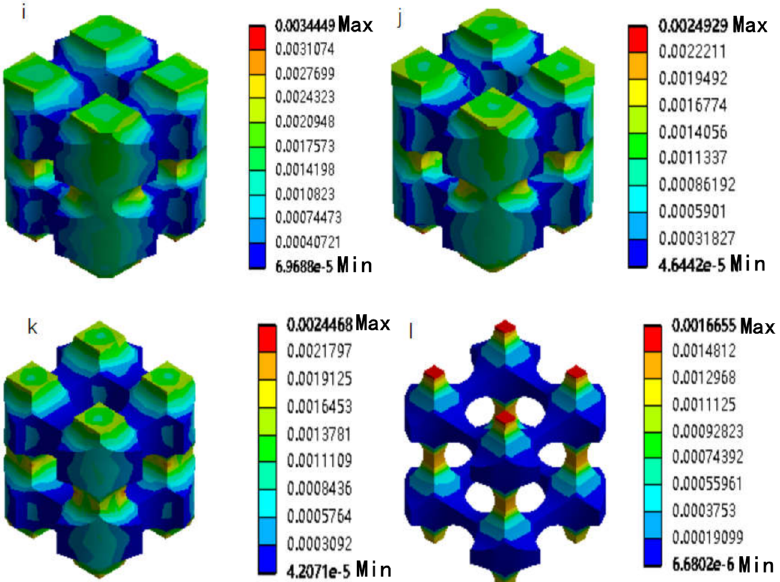
Figure 6. Total deformation nephogram of porous scaffolds with aperture size of 200 µ m, 300 µ m, 400 µ m and 500 µ m, respectively ( a – d ), Stress analysis nephograms of porous scaffolds with aperture sizes of 200 µ m, 300 µ m, 400 µ m and 500 µ m ( e – h ), Strain analysis nephograms of porous scaffolds with aperture sizes of 200 µ m, 300 µ m, 400 µ m and 500 µ m ( i – l ).